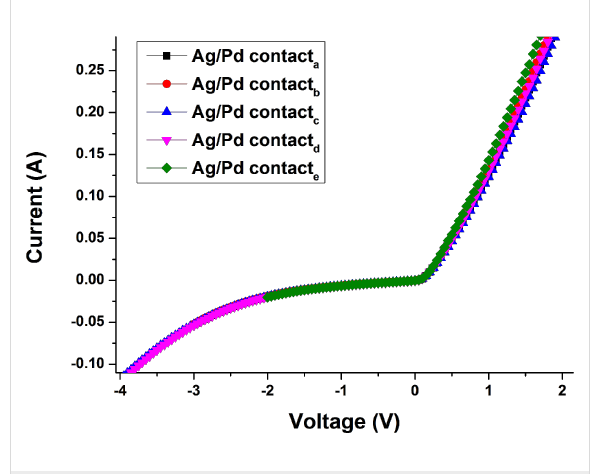
Figure 3: Current–voltage characteristics of the vertical device after the Pd contacts were glued with conductive silver paste.